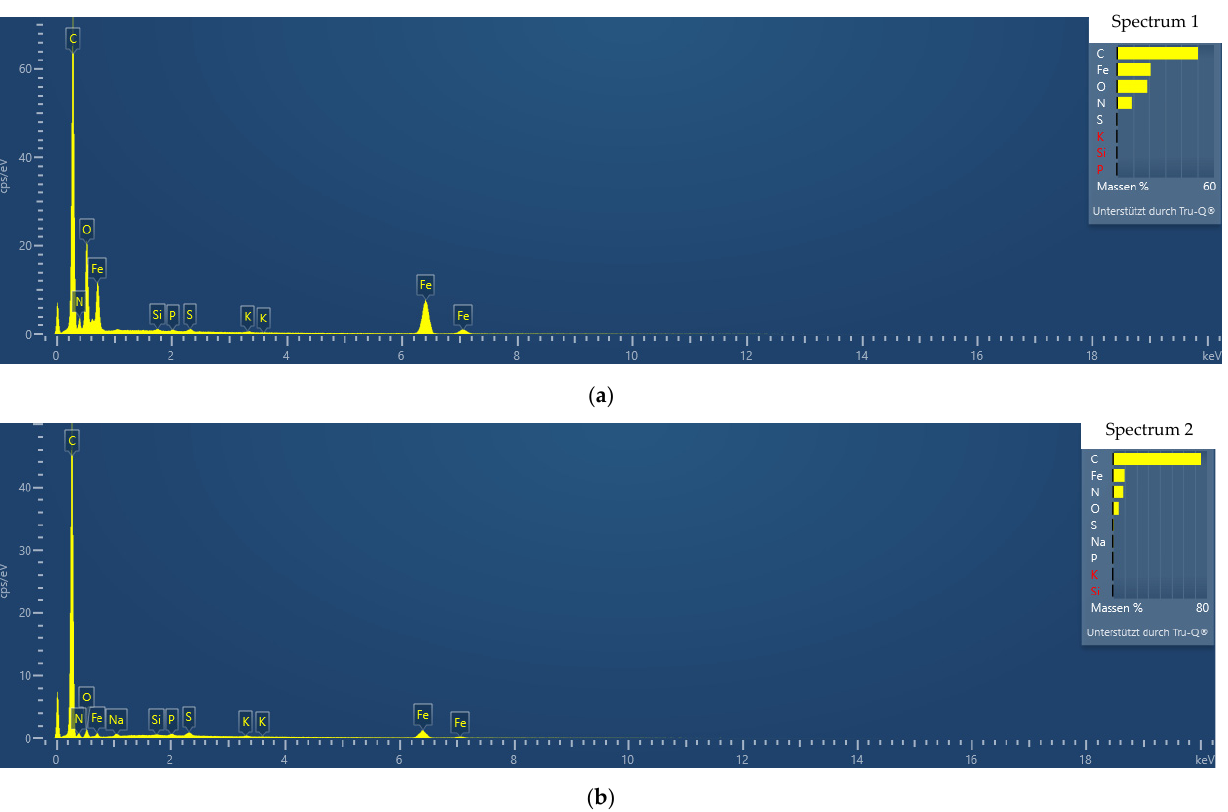
Figure 9. EDS spectra of PAN/magnetite nanofiber mat ( a ) spot on a bead; and ( b ) spot on a nanofiber.